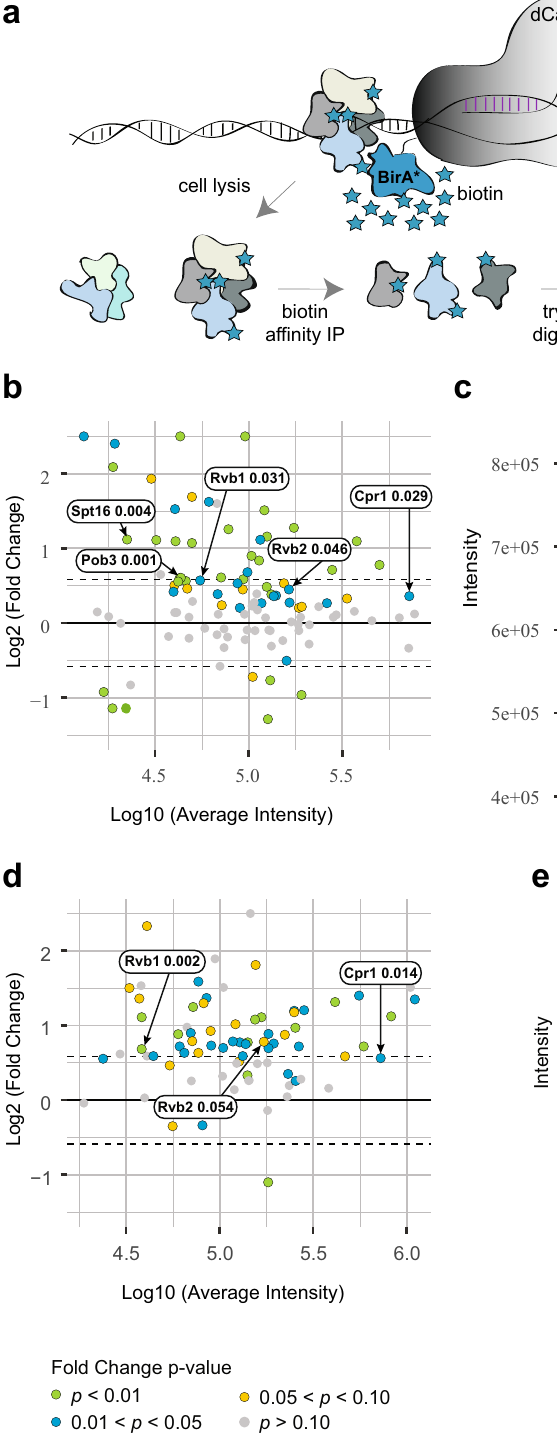
Fig. 5 | Chromatin remodeling subunits bind GRS site near INO1 locus. a BirA*- dCas9 approach designed to target protospacer adjacent motif (PAM) sites in the vicinity of GRS I site by using different sgRNAs for site-speci fi c binding of BirA*- dCas9 and biotinylation of proximal proteins. Proteins were then af fi nity puri fi ed with streptavidin, digested, and analyzed by mass spectrometry. b , d Micro array (MA) plots representing average protein intensities from biological triplicates from sgRNA-BirA*-dCas9 samples S5 ( b ) and S7 ( c ) plotted against protein quantity fold changes from these sgRNA-BirA*-dCas9 samples over those from their respective negative control triplicates (BirA*-dCas9). Protein fold change p -values calculated